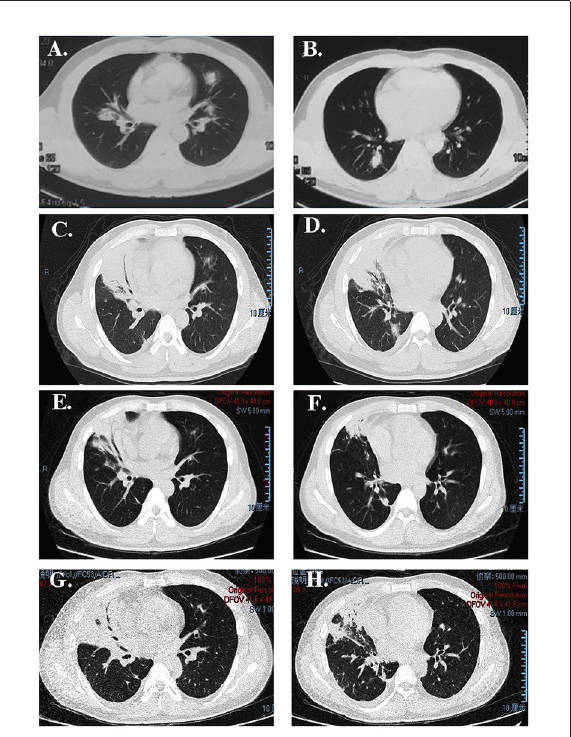
FIGURE1 CT image showing (A, B) some nodules on the right upper lobe; (C, D) consolidation of the right upper lobe with an air bronchogram after antibiotic therapy administration in our hospital; (E, F) that the lesion was absorbed after treatment with dexamethasone; (G, H) more extensive lesions than previously observed after re-administering corticosteroids.